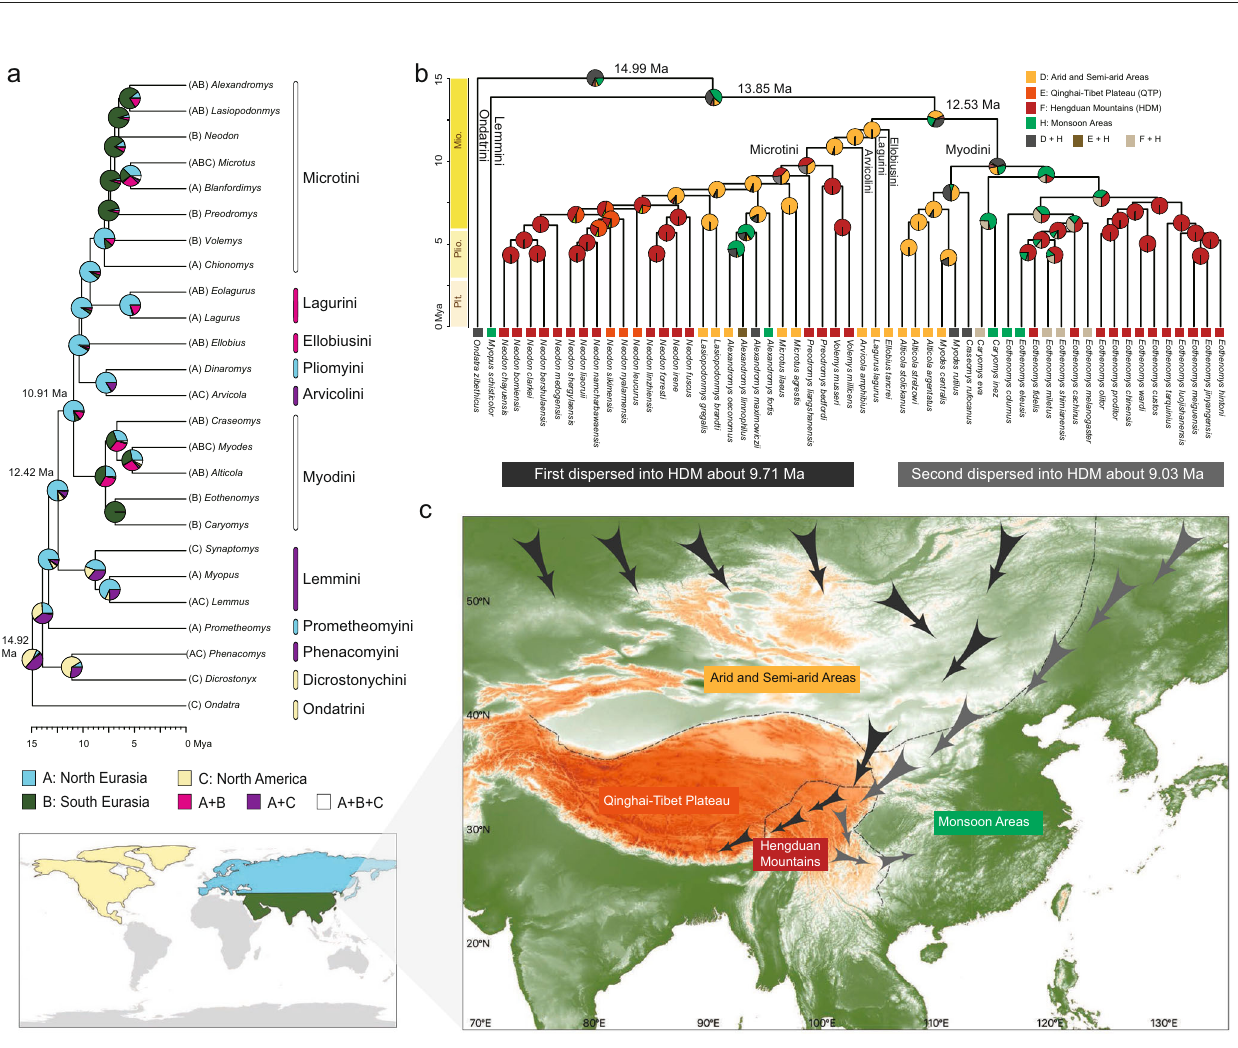
Fig. 3 Divergence times and dispersal history of voles. a Ancestral range reconstruction of global Arvicolinae based on the time tree from the genus-level mitochondrial genome dataset and the DEC + J model. b Reconstruction of the ancestral ranges of the HDM voles and related species based on the time tree of the species-level nuclear dataset and the DEC + J model. The distribution of relevant vole species was divided into four areas: arid and semiarid areas, the Qinghai-Tibet Plateau, the Hengduan Mountains and monsoon areas. Circles on the nodes represent the set of possible ancestral areas, and the color is associated with the area legends. c Possible migration routes of voles into the Hengduan